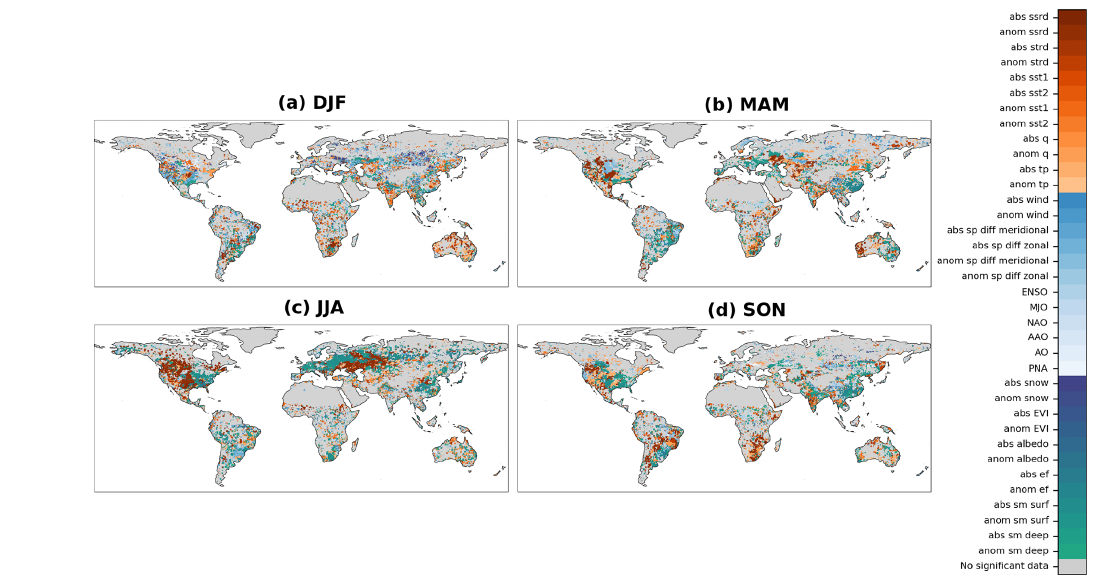
Figure A3. Seasonal cycle of each grid cell’s most relevant Earth system variable in terms of its relationship with forecast error. The three groups of colors represent the three groups of Earth system variables: climate (orange), circulation (light blue), and land surface (viridis). Grid cells with no significant Spearman correlation are colored in gray. A NetCDF file with these data is provided in the Supplement.